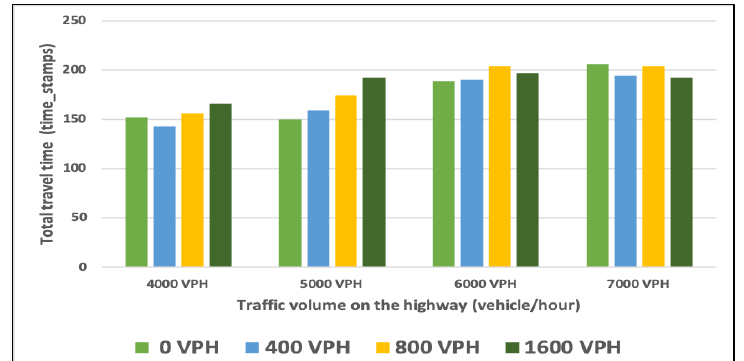
Figure 9. Total travel time for rerouting around accident during different traffic volumes with different arterial loads.